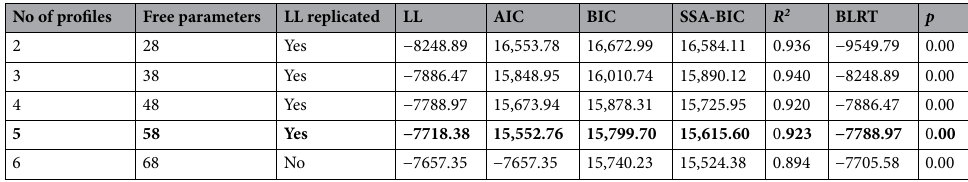
Table 2. Model fit information for latent profile analysis. Information for the best fitting model is in bold.